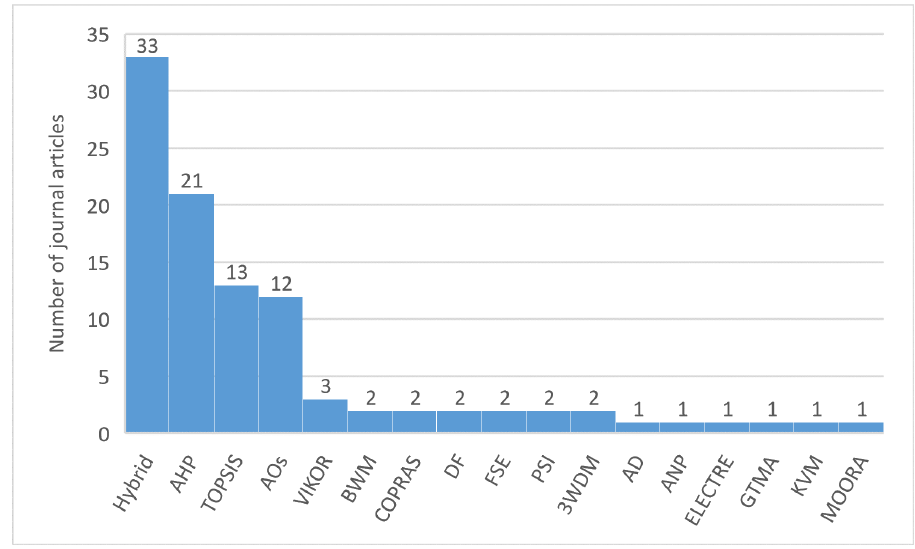
Figure 6. Distribution of the MADM methods applied in AM.